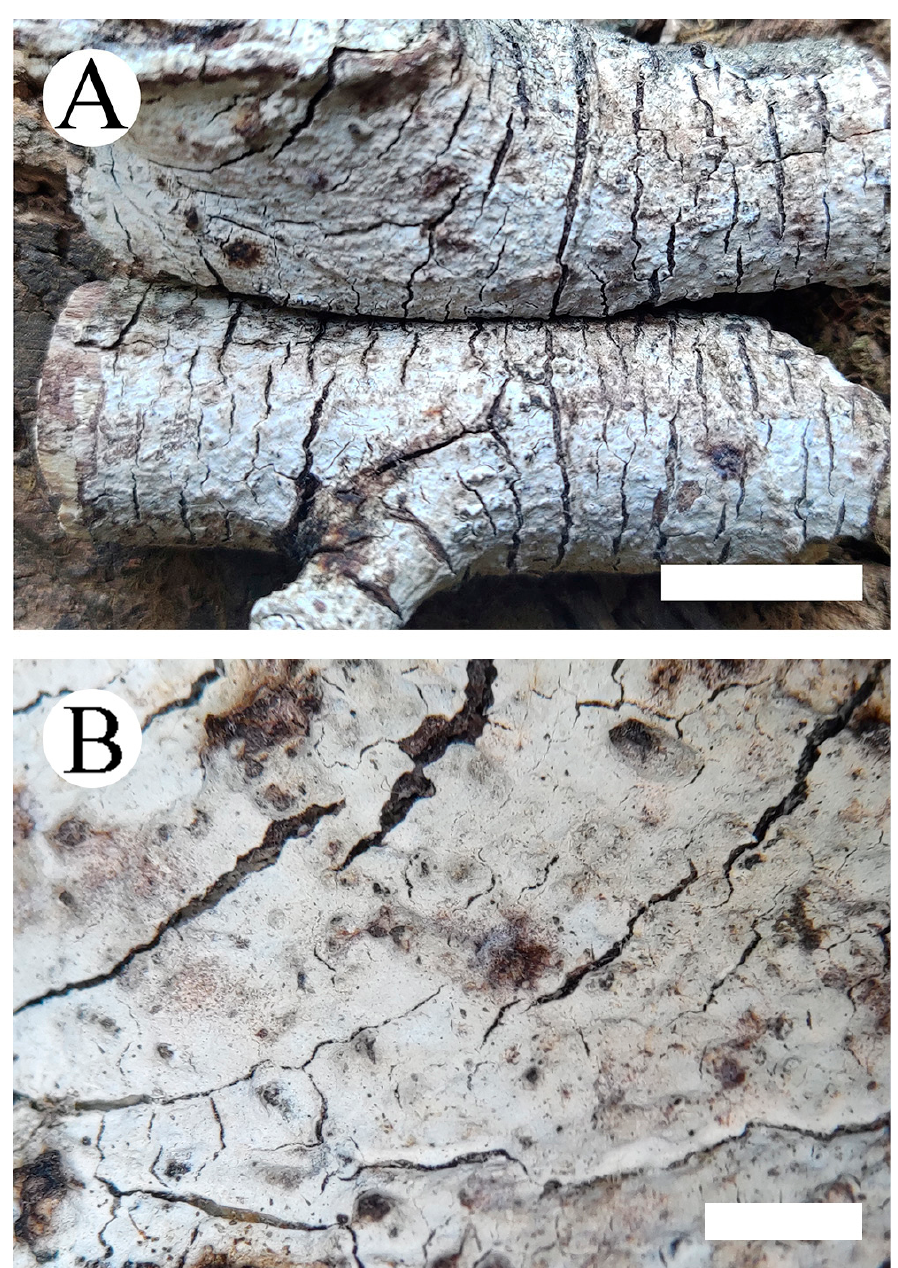
Figure 3. Basidiomata of Heteroradulum niveum . Bars: ( A ) = 1 cm; ( B ) = 2 mm (holotype). Spores— Basidiospores allantoid, colorless, smooth, thin-walled, IKI–, CB–, (6.2– )6.5–13.5(–14) × (2.5)2.7–5.5(–5.8) µm, L =10.02 µm, W = 4.38 µm, Q = 2.1–2.4 (n = 150/5).